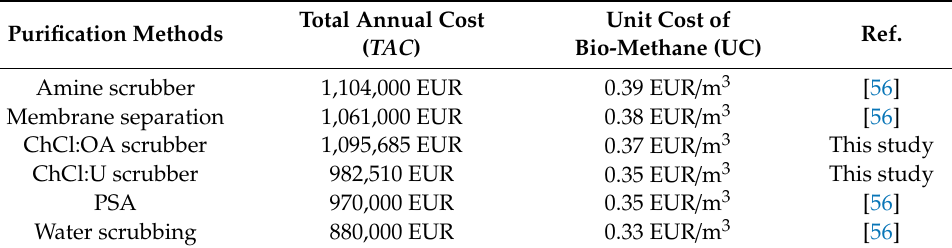
Table 9. Comparison of economic